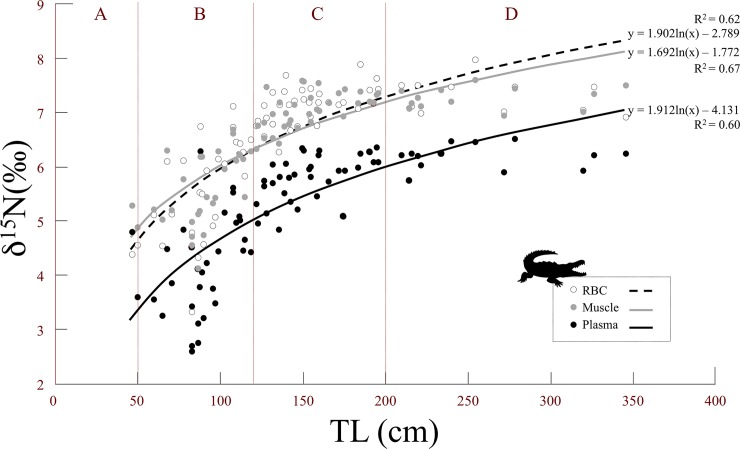
Relationship between black caiman δ15N values and total length (TL).Each circle represents one individual (white = RBCs, gray = muscle, and black = plasma). The equation, the coefficient of determination, and the best-fit curve are shown for the significant models (muscle F1,72 = 103.80, P < 0.001; plasma F1,72 = 69.51, P < 0.001; and RBCs F1,72 = 90.43, P < 0.001).